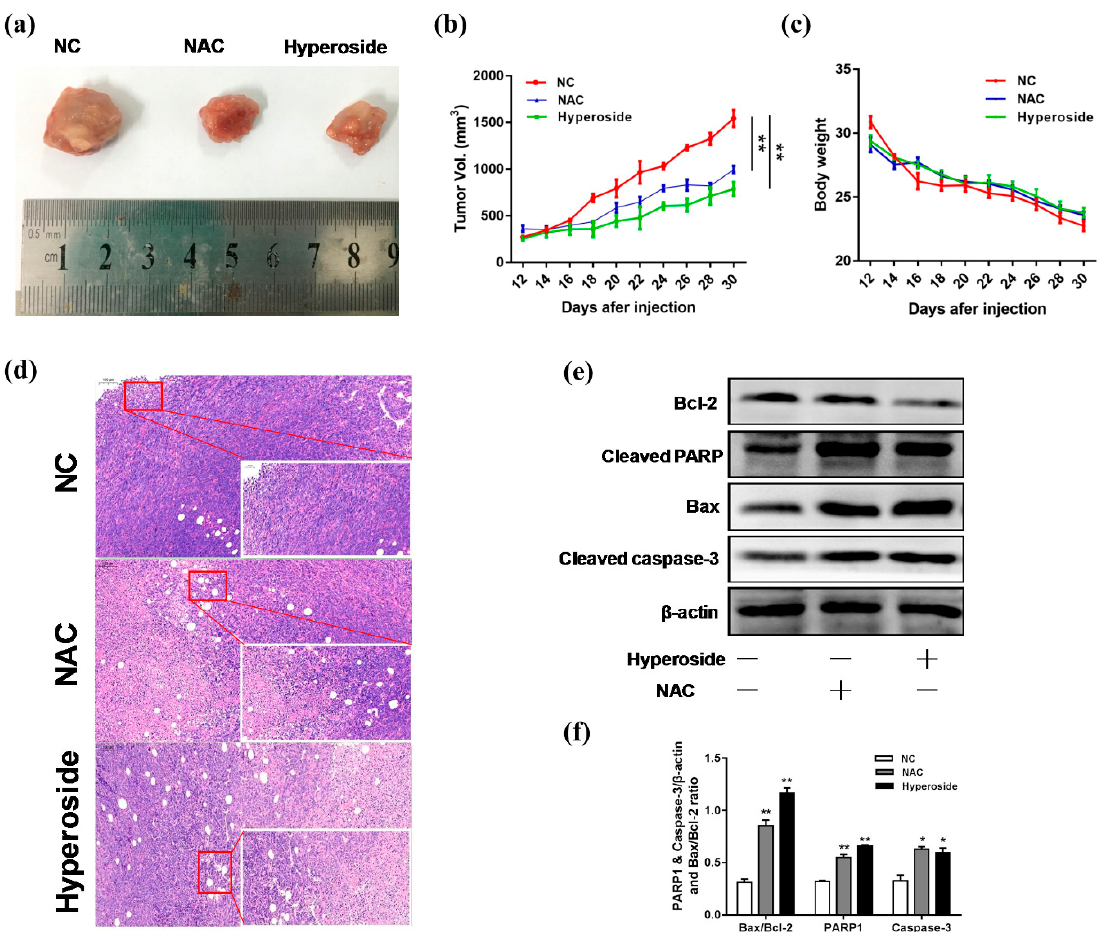
Figure 5. Effects of hyperoside on tumor growth. Balb/c mice were divided into three groups (normal control (NC) group, hyperoside group, and NAC group). ( a – c ) Day 0 was the day subcutaneous homotransplant mouse model was created. On Day 12, drugs were injected into the tumor. The volume of the tumor and mouse weights were measured every two days ( n = 5 per group). On Day 30, the mice were killed, and samples were collected. ( d ) H&E staining was performed. ( e , f ) Western 2. β -actin was used for normalization. Data are expressed as mean ± SD of three independent experiments. * p < 0.05, ** p < 0.01 (Student’s t -test).